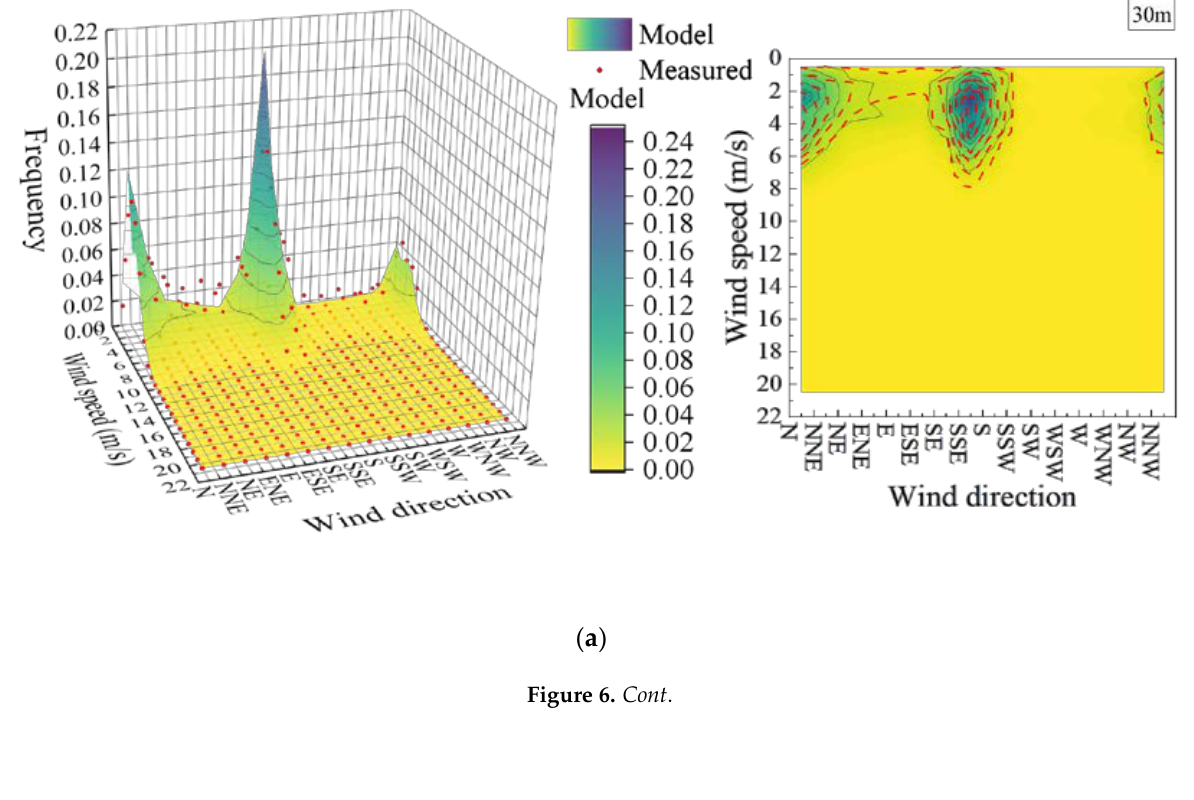
Table 8. Goodness-of-fit test of AL model.